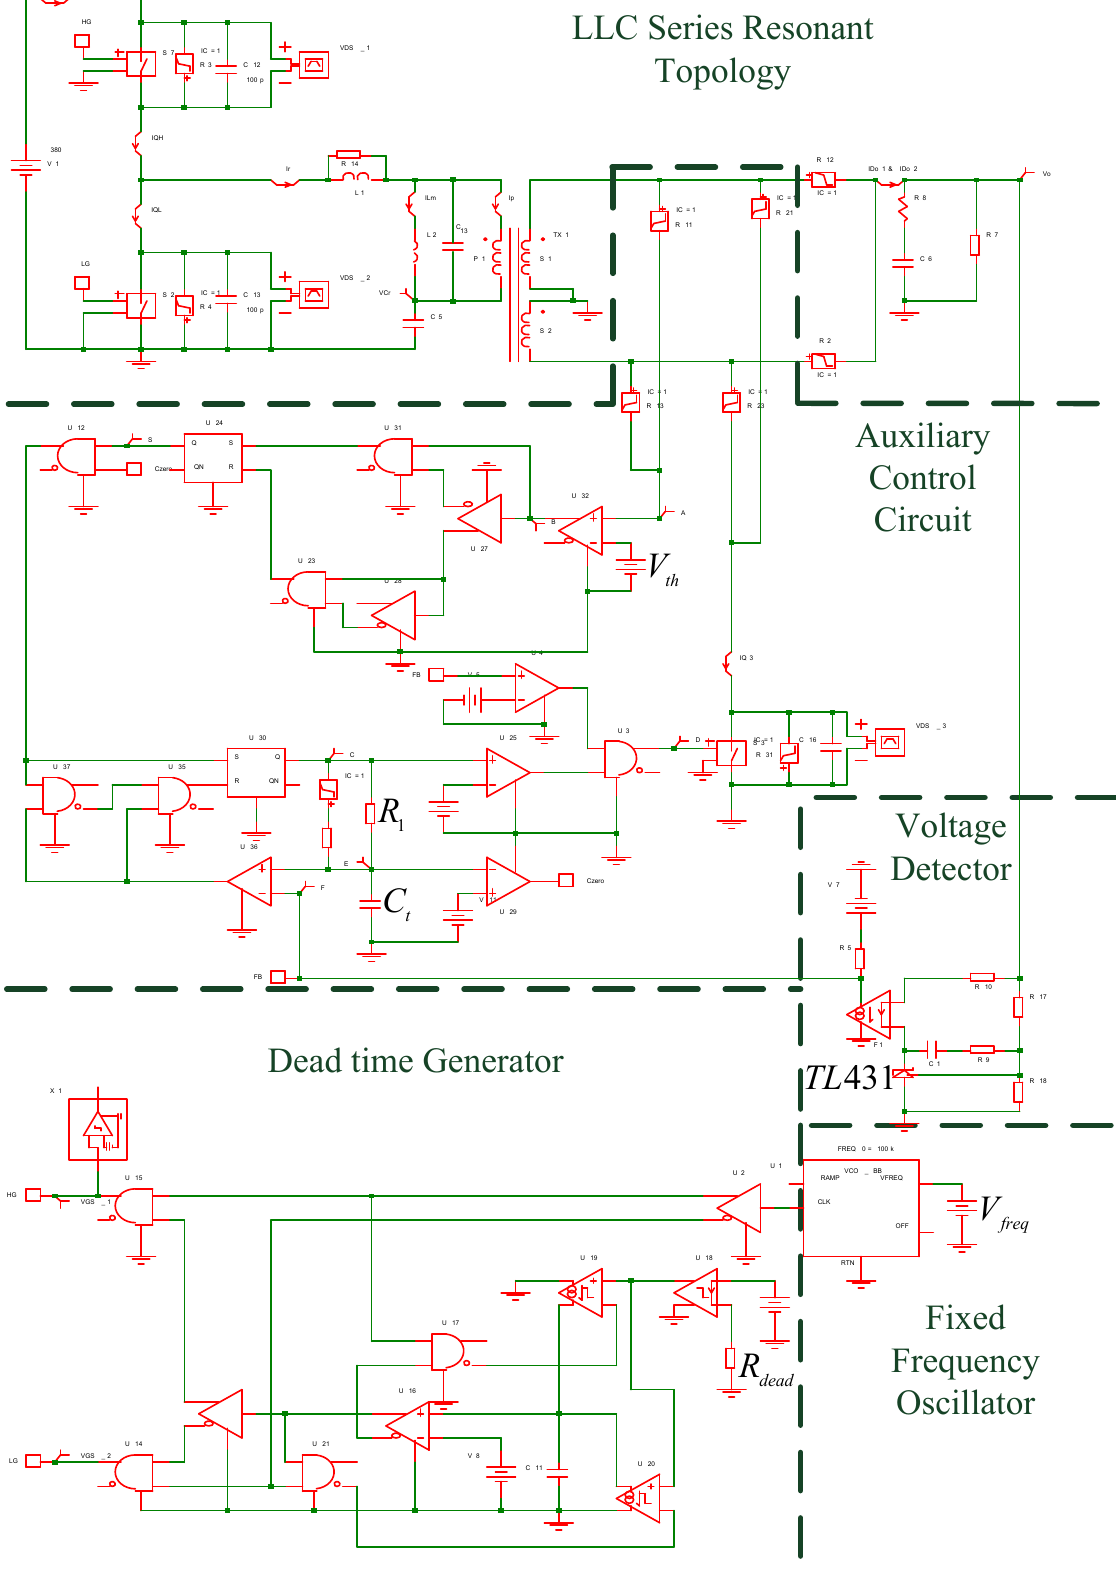
Figure 22. Novel LLC simulation